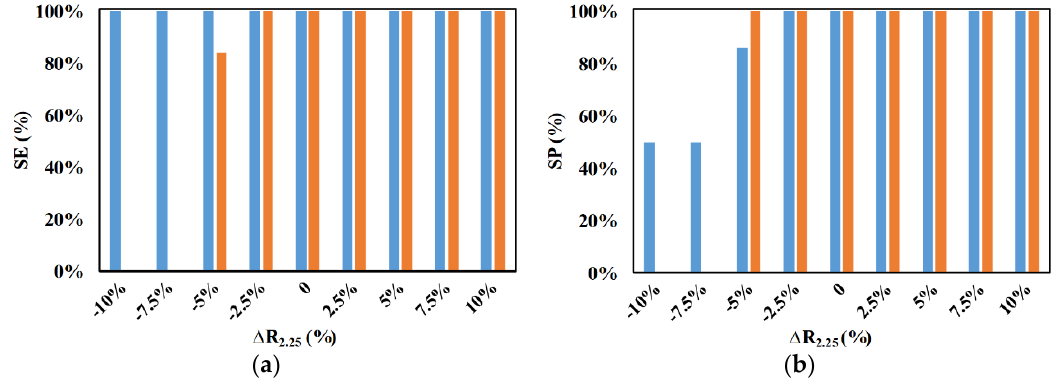
Figure 15. Effect of variations in radius of big microparticles on SE and SP for ( a ) ■ 2 μm and ( b ) ■ 2.25 μm (at 0%) ( d f = 60 μm, l f = 120 μm, d s = 60 μm, l s = 120 μm, w f = 6 μm, w s = 6 μm, n f = 200, n s = 200, V 1 = 3 V pp , V 2 = 15 V pp , V 3 = 15 V pp V 4 = 3 V pp , H ch = 50 μm, W ch = 50 μm, 0 < W o,2.25 < 30 μm, 30 μm < W o,2 < 50 μm, N 1 = N 2 = 10 MHz, N 3 = N 4 = N cr,2 = 473 kHz).